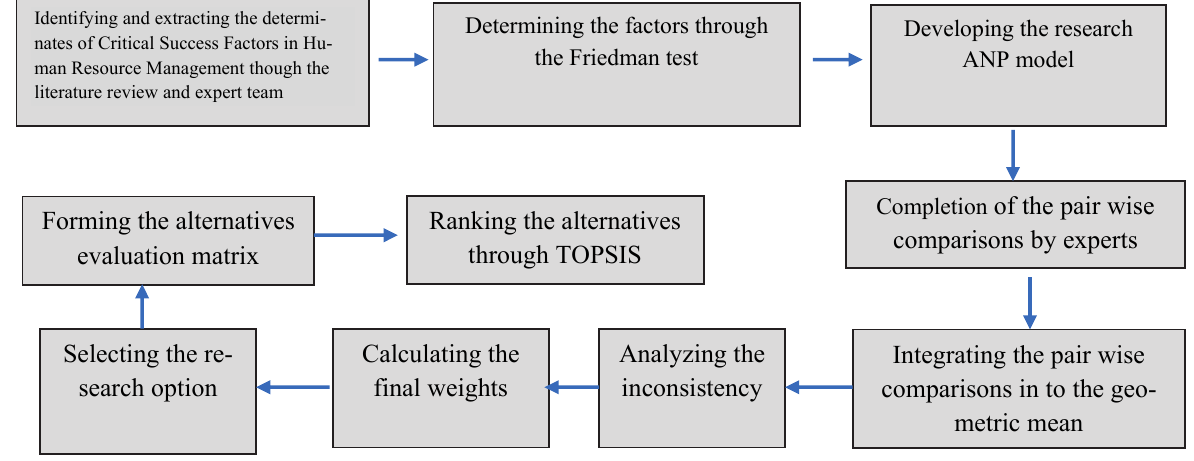
Fig. 1. Frame work proposed Research process